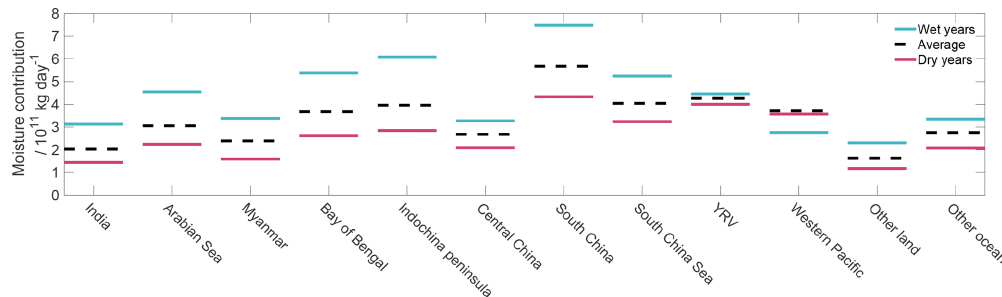
Figure 10. Moisture contribution during the five driest (1981, 1985, 2003, 2006, 2013) and wettest (1993, 1995, 1996, 1998, 1999) summers. The average contribution for all summers is also shown with dashed lines. The extent of the source regions is defined in Fig.